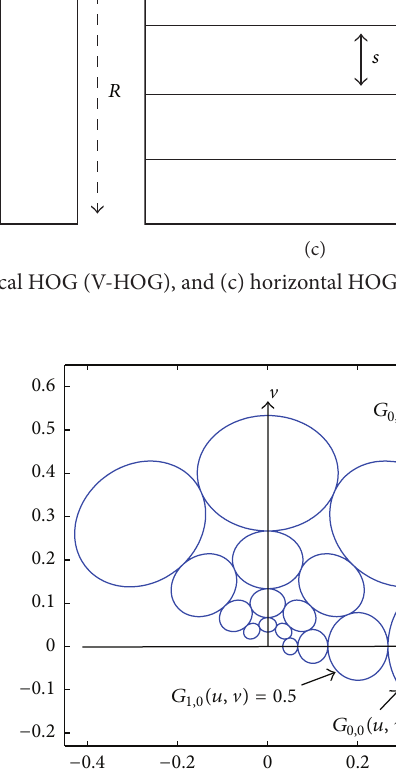
Figure 3: Frequency response of the Gabor filter bank. The contours indicate the half-peak magnitude of the filter responses in the Gabor filter family. The filter parameters used here are 𝐾 = 4 , 𝑁 = 4 , 𝑎 = 2 , and 𝐹 0 = 0.4